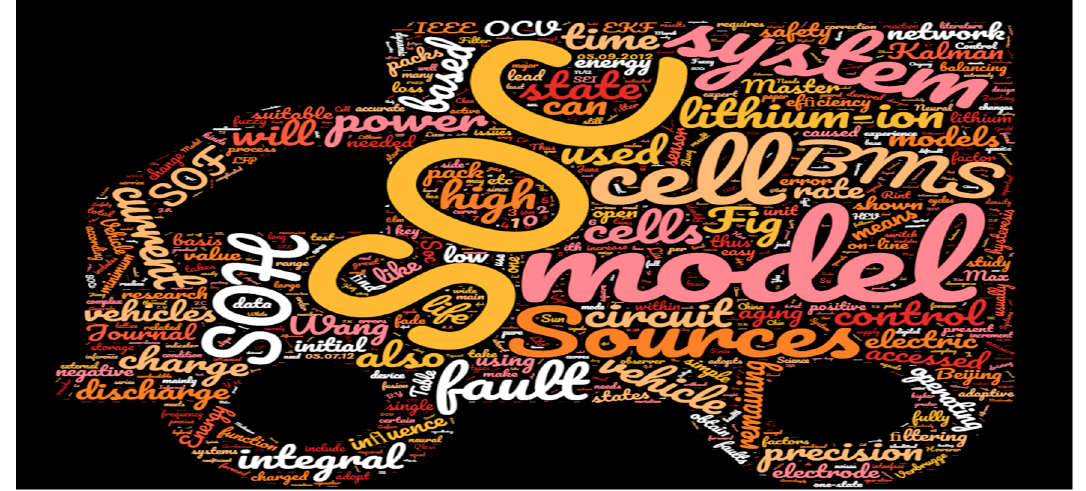
Figure 16. Visualization of top cited paper words in “Wordcloud”.